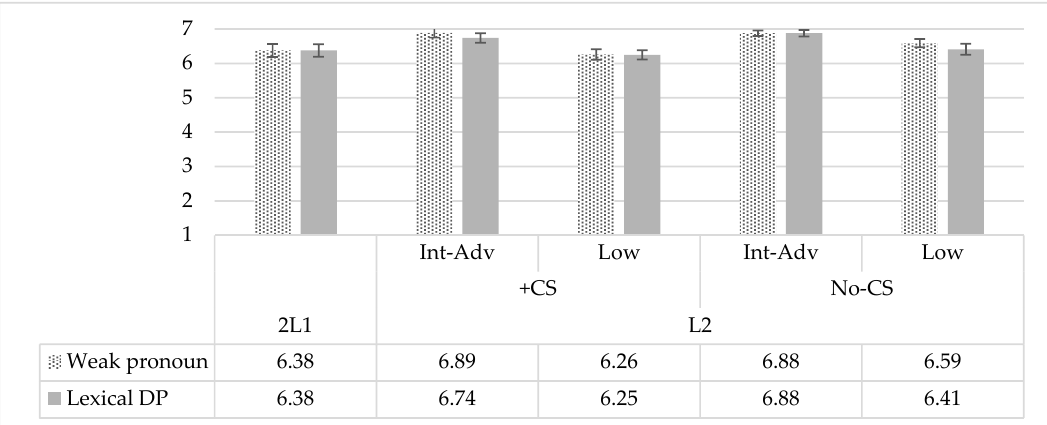
Figure 7. Monolingual Spanish subject stimuli ratings by group and type.